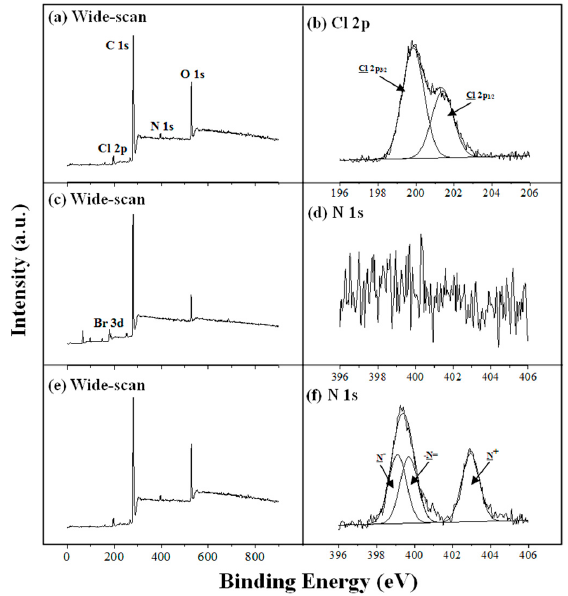
Figure 4. ( a ) XPS wide-scan spectrum of P(CMS- alt -NPM)1, ( b ) Cl 2p core-level spectrum of P(CMS- alt -NPM)1, ( c ) XPS wide-scan spectrum of PFC6Br, ( d ) N 1s core-level spectrum of PFC6Br, ( e ) XPS wide-scan spectrum of PFC6N 3 , and ( f ) N 1s core-level spectrum of PFC6N 3 .